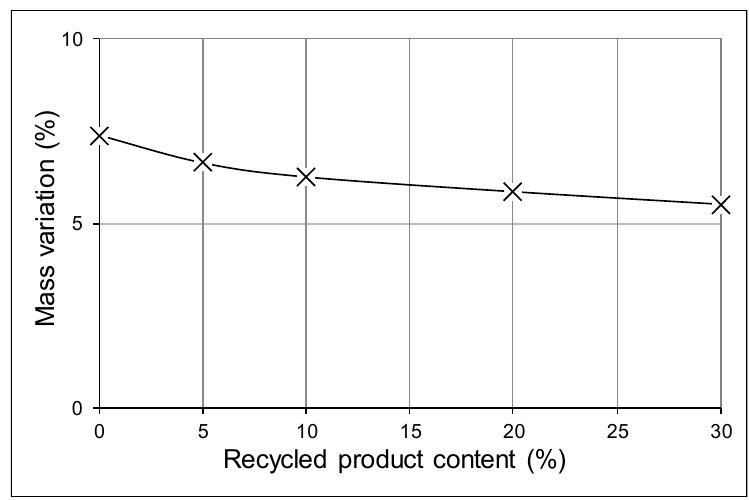
Figure 8. Mass variation at 900 °C.